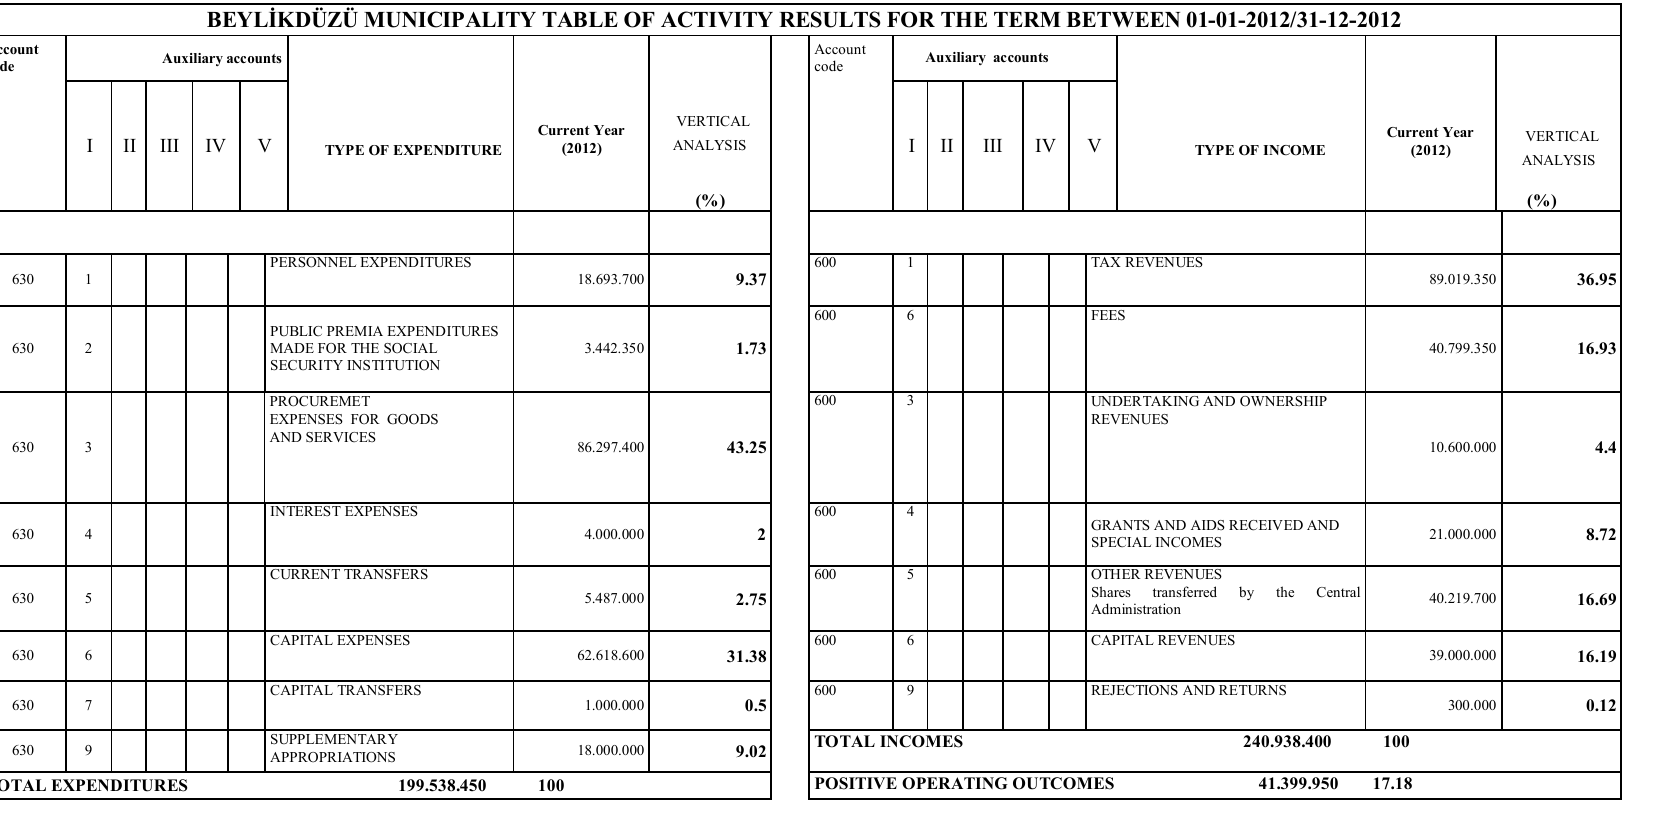
Table 2: Beylikdüzü Municipality Table of Activity Results for Year 2012 Vertical